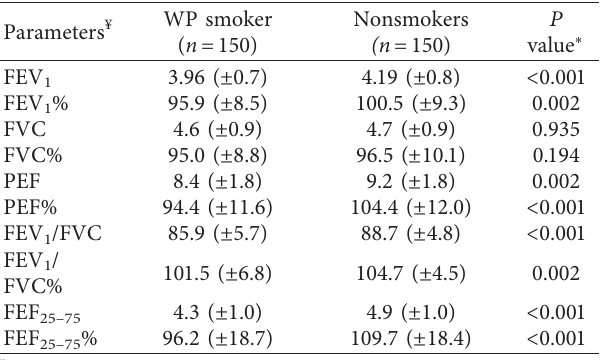
Table 2: Spirometry results comparing waterpipe smokers and